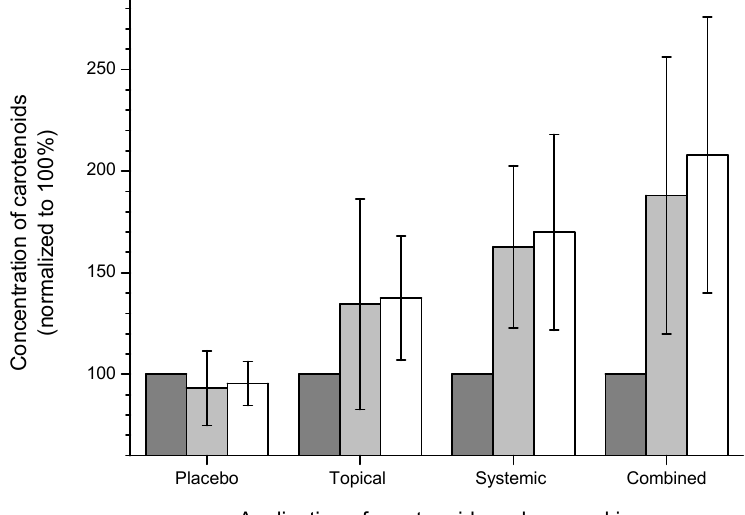
Figure 3. Comparison of the carotenoid concentration on the cheek before treatment (black column), after 4 weeks (grey column) and after 8 weeks (white column) of treatment with carotenoid-containing